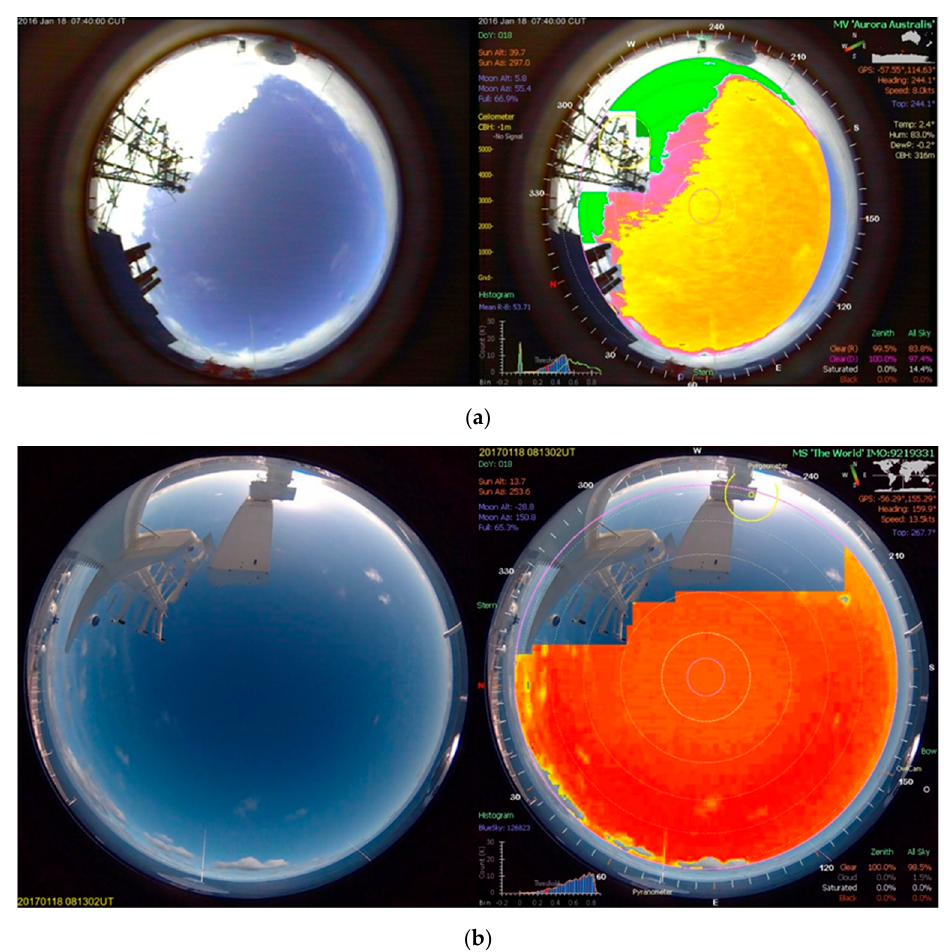
Figure 3. Raw and processed images for ( a ) 2015 to 2016 RSV Aurora Australis voyages and ( b ) 2017 MS The World voyage when the sun is behind the ship’s superstructure.